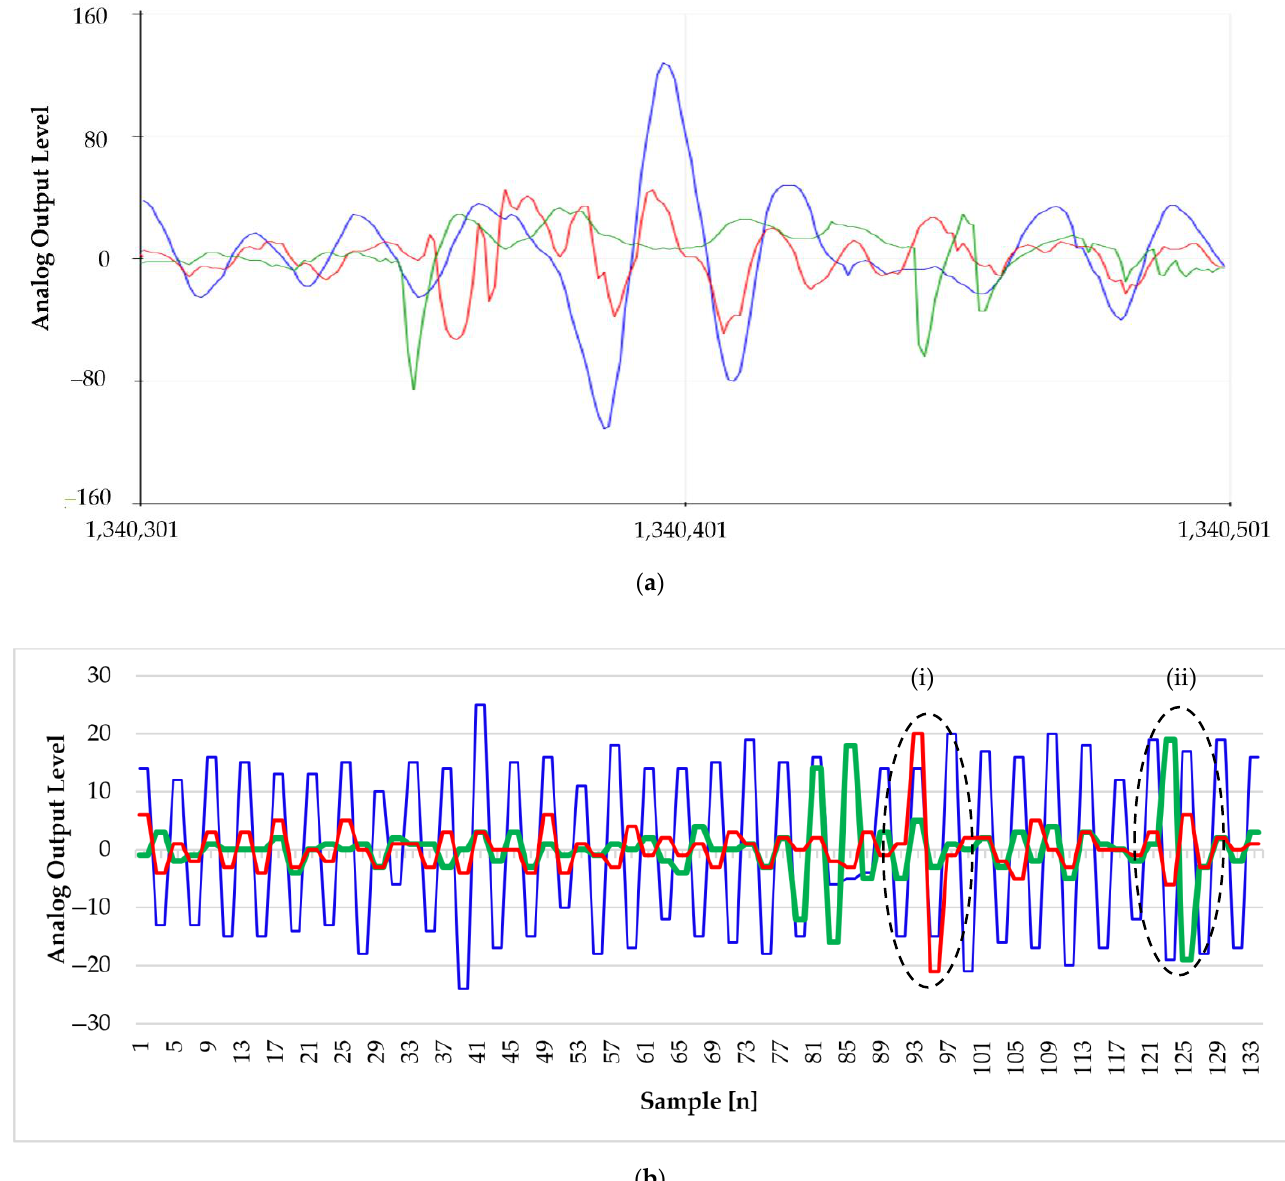
Figure 3. Representative signals acquired via multi-sensor accelerometers. ( a ) Signals plotted by Arduino SDK serial plotter. ( b ) Simulation of external noise generated via the hammer module by changing the displacement ((i) and (ii), respectively). Data were stored on a SD card and plotted with Microsoft Excel software. For both graphs, the x -axis is in number of sample and the y -axis represents the amplitude in bit. Green line: ceiling noise; red line: bed noise; blue line: signal detected by the accelerometer fixed on the module emulating the abdomen movement.